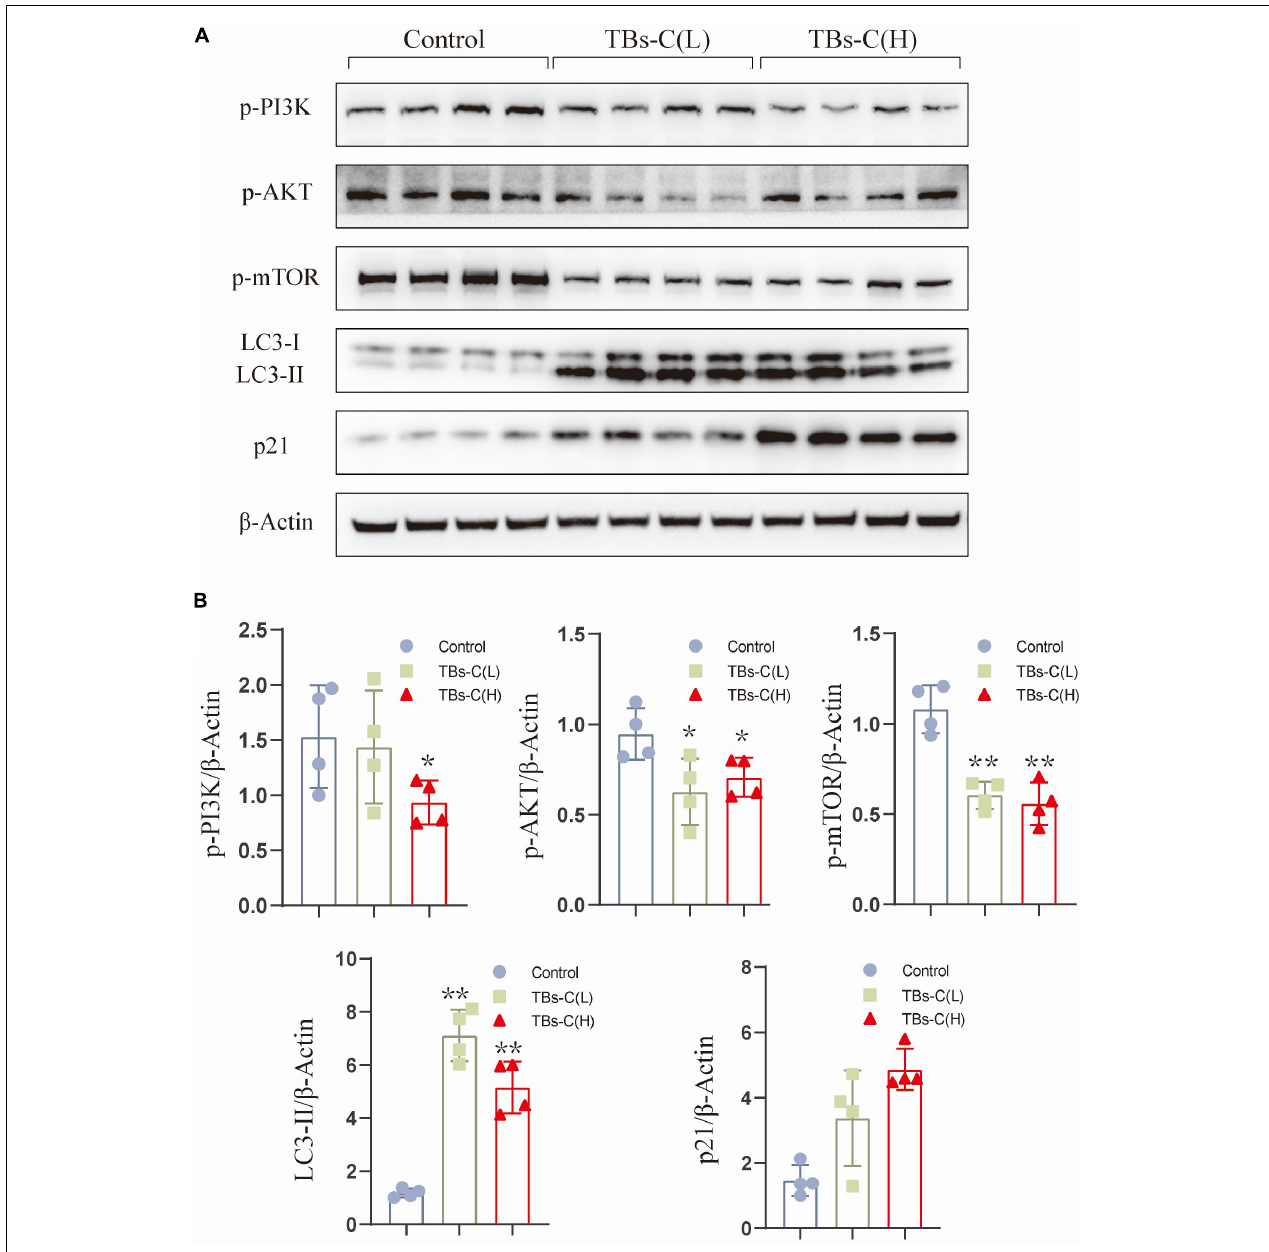
FIGURE 9 | TBs-C inhibits the PI3K/AKT/mTOR pathway in vitro . (A) The protein was extracted from tumors in each experimental group, and the expression of p-PI3K, p-AKT, p-mTOR, p21, and LC3 were detected by Western blotting. (B) Density analysis of Western blotting results among the study groups. TBs-C